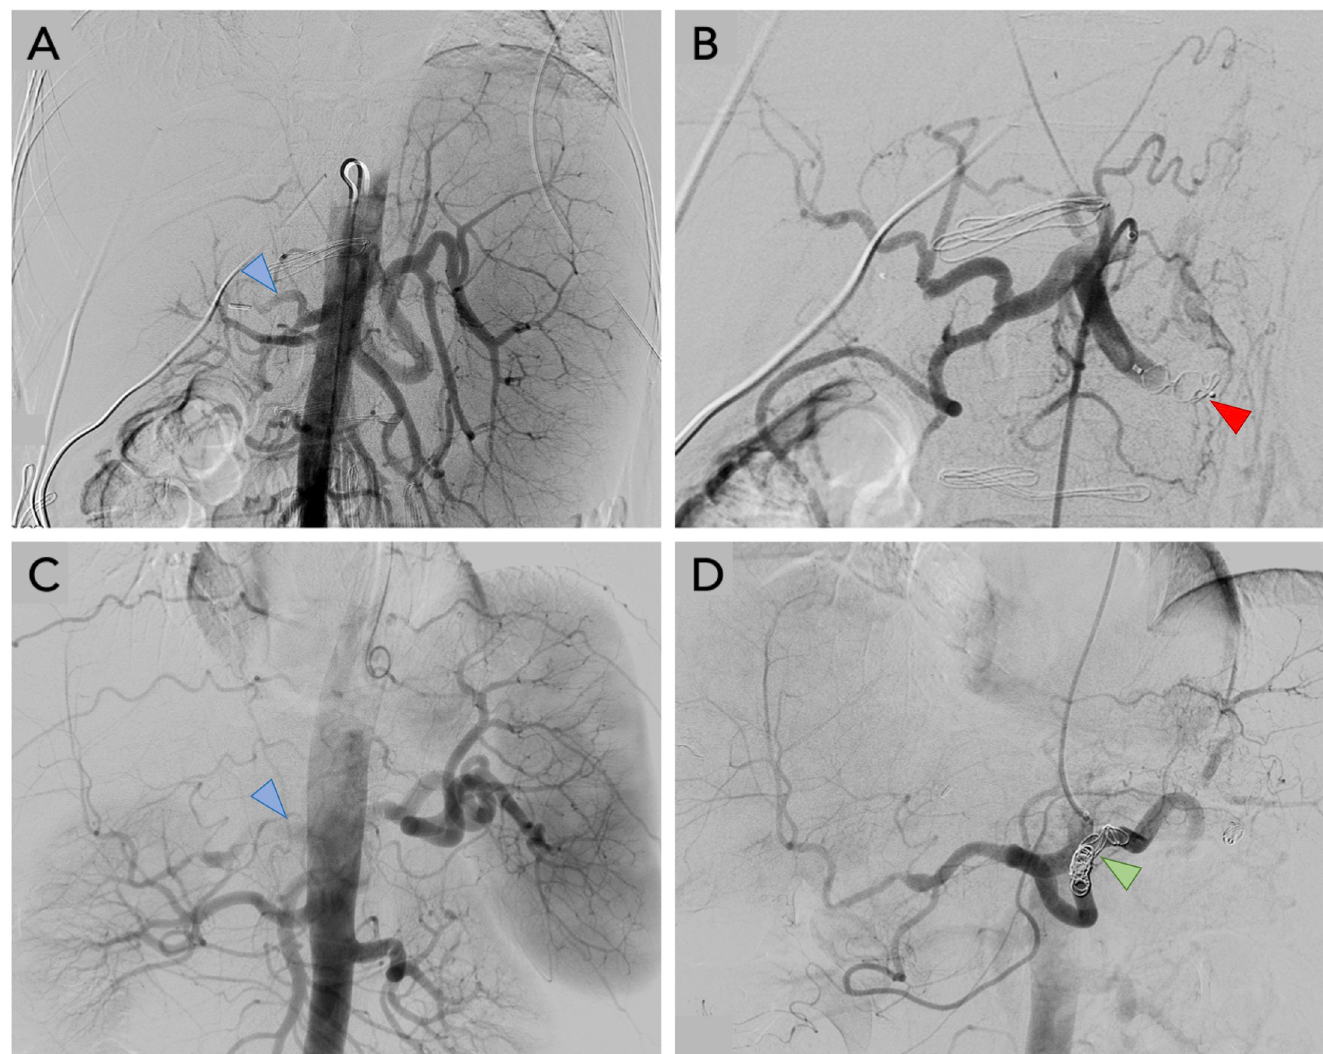
Fig 2. Abdominal DSA. A-C. Pre-intervention celiac angiography shows hampered hepatic arterial flow with delayed contrast filling of the hepatic artery (blue arrows) as well as early and strong contrast filling of the enlarged splenic artery. B-D. Post-interventional celiac angiography shows significantly improved hepatic arterial flow and delayed contrast filling of the splenic artery. B. shows embolization of the SA using an Amplatzer venous plug (red marker), D. shows an embolization using coils (green marker).